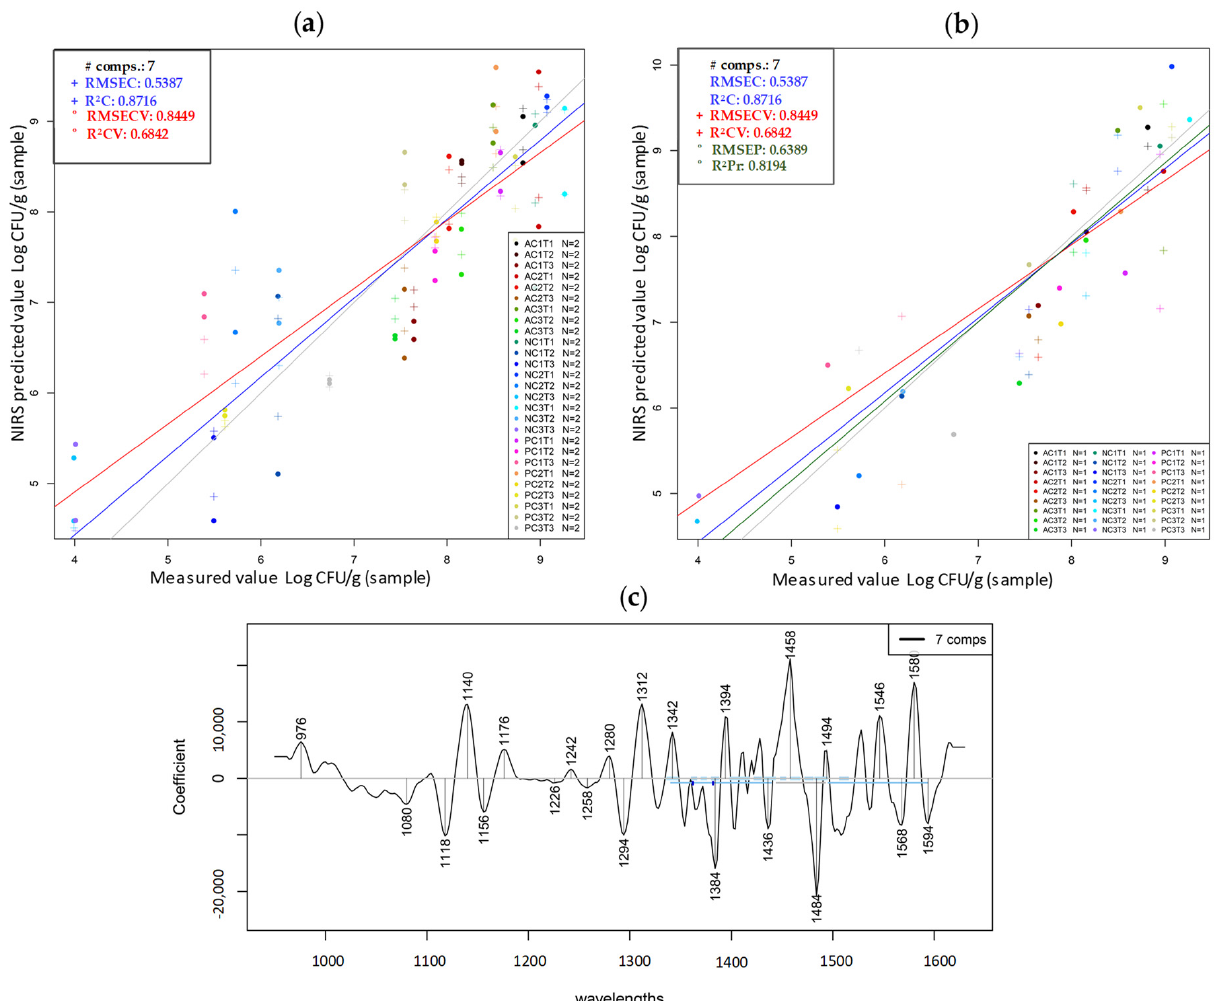
Figure 6. Prediction of the CFU counts of probiotic samples by PLSR. ( a ) PLSR model used for calibration (C) and cross-validation (CV). R2 and R3 are the repetitions selected for the model (N = 2). ( b ) PLSR model for the prediction of samples (Pr). R1 is the repetition selected for prediction (N = 1). ( c ) Main contributing wavelengths of 1950–1630 nm for the PLSR